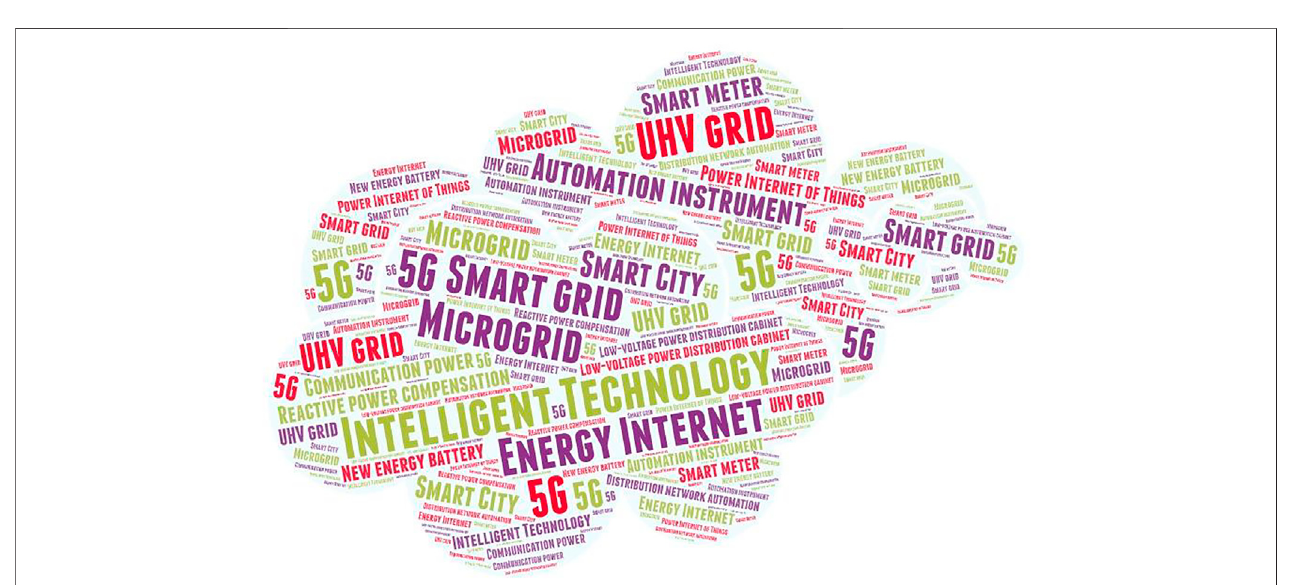
FIGURE 4 | Smart grid word cloud